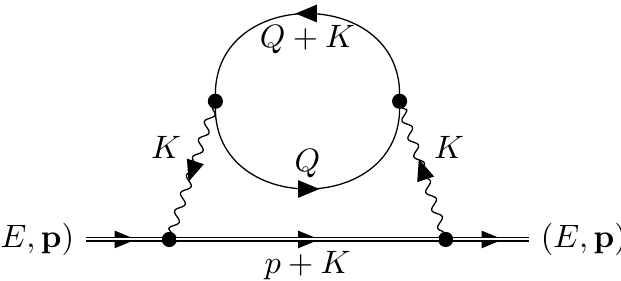
Figure 1. A two-loop contribution to γ ( E , (cid:126) p ) . The polarization tensor Π ( 1 ) ( k 0 , k ) is the Hard Thermal Loop ( HTL ) one from Equation